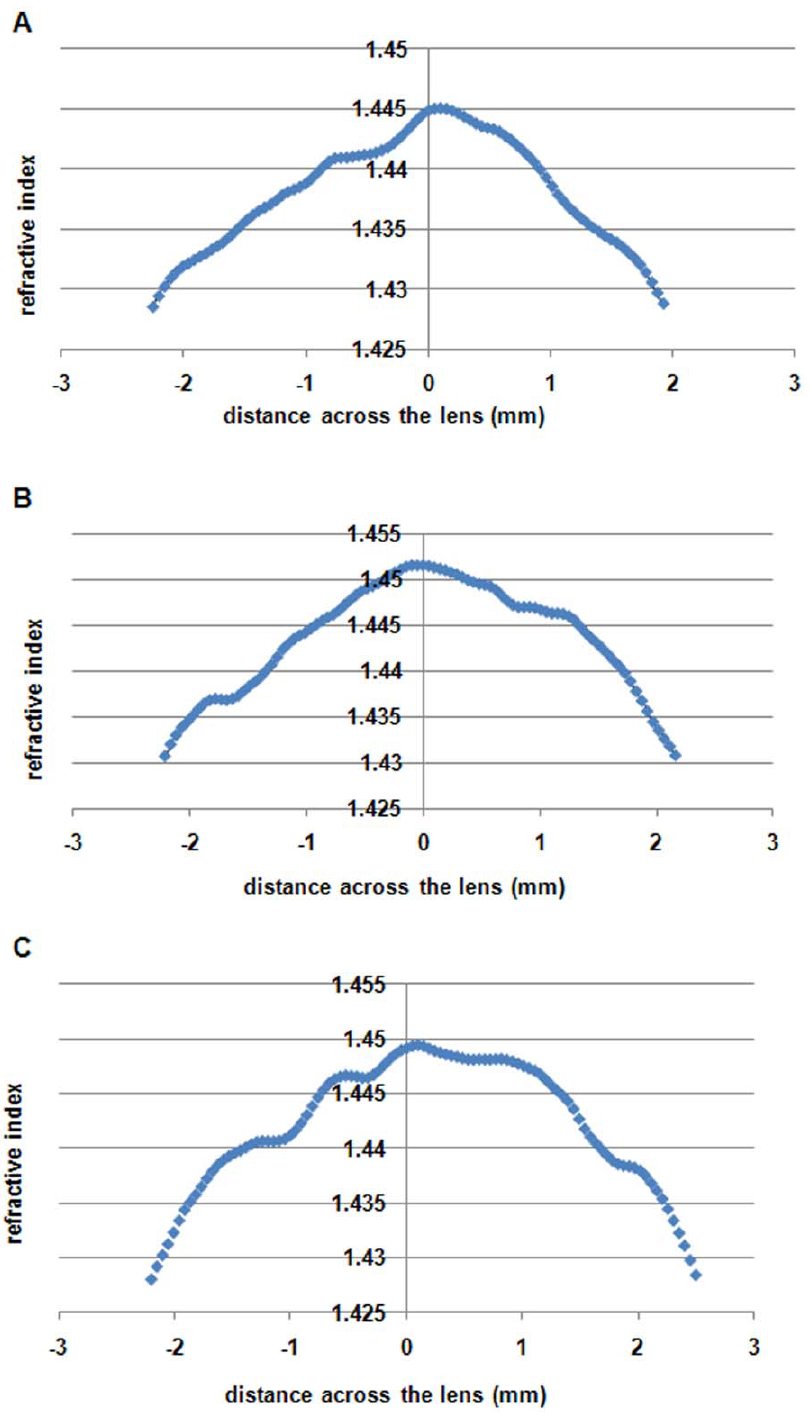
Figure 4. Central region of refractive index profiles along the optic axis (sagittal plane) in three porcine lenses plotted against the distance across the lens in mm, from the anterior (-ve x-axis values) to the posterior ( + ve x-axis values) poles.